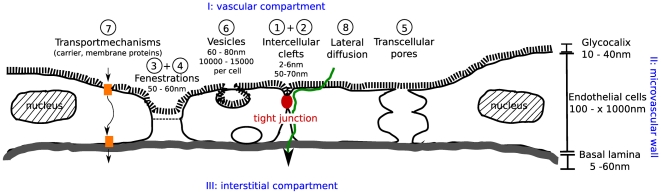
Paracellular and transcellular pathways [48].